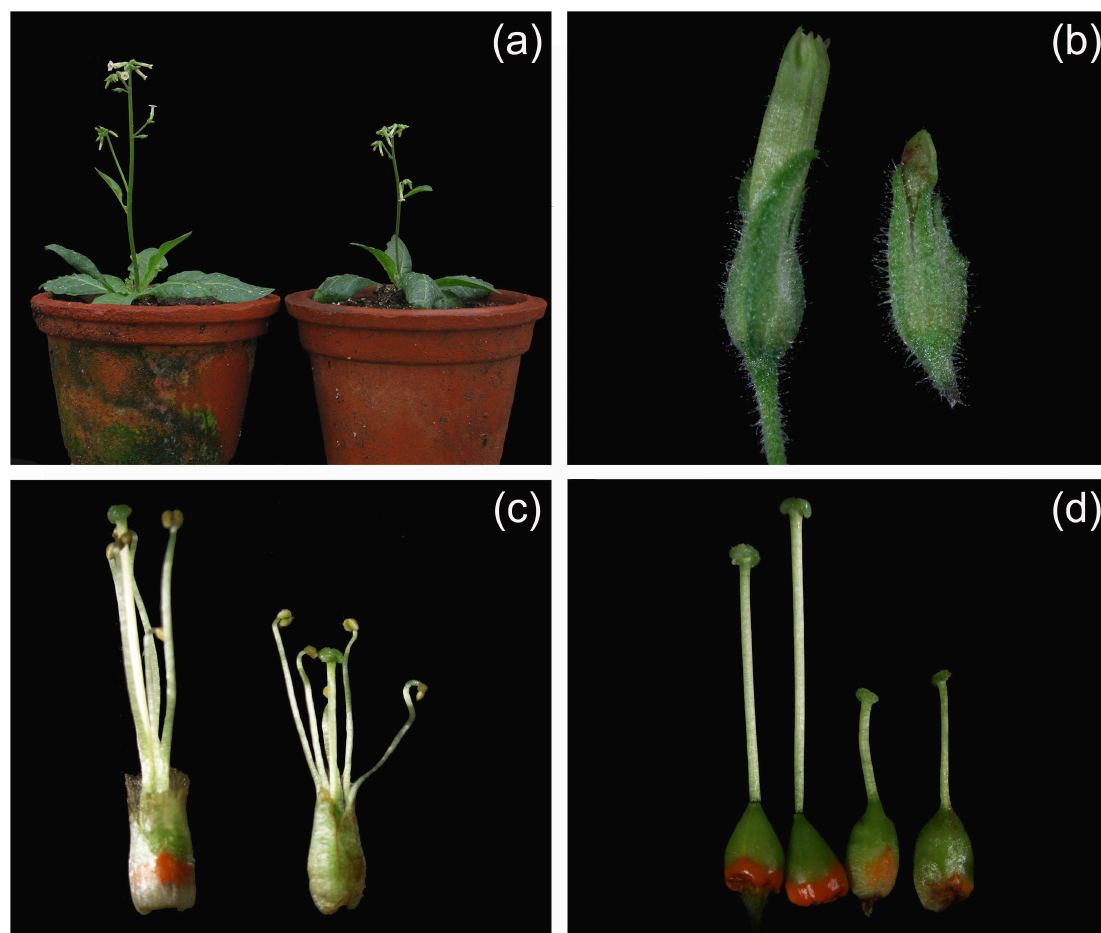
Fig 6. Phenotypic comparison between non-transgenic and transgenic N . rotundifolia lines with overexpression of 35S :: TePI . (a) The non-transgenic (left) and transgenic plant of 35S :: TePI (right). (b) Flower buds from the non-transgenic (left) and a transgenic plant of 35S :: TePI (right). (c) Stamens and pistils from the non-transgenic (left) and a transgenic plant of 35S :: TePI (right). (d) Carpelsfrom the non-transgenic (left two) and a transgenicplant of 35S :: TePI (right two). The ovary surface of the transformants was rough. The petal, stamen and pistil of transgenic plants were significantshorter than the non-transgenic plants.